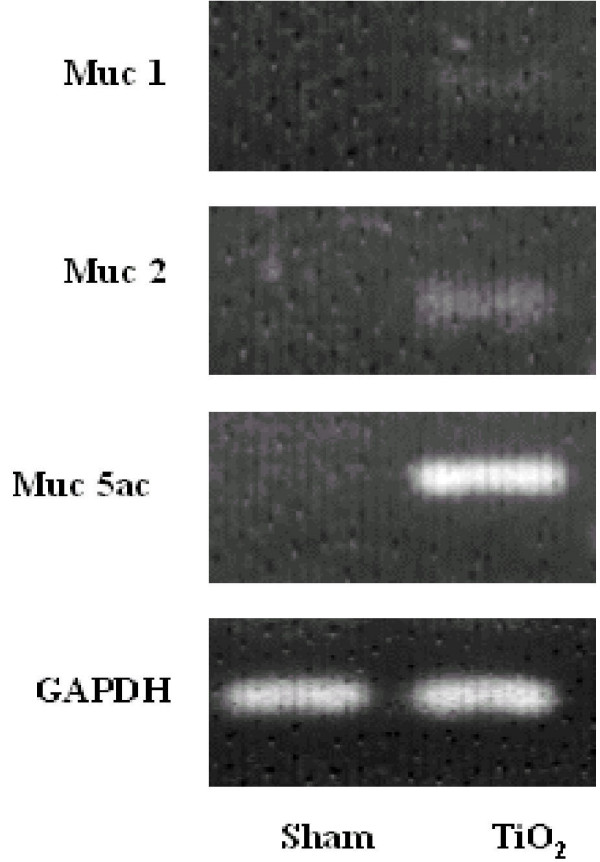
The expression of Muc1, Muc2 and Muc5ac mRNA in TiO2 treated rats. Rats were treated with TiO2, as described in Methods. Twenty-four hours after treatment, the levels of the Muc gene transcripts in the trachea were quantified using RT-PCR. GAPDH was used to ensure an equal loading of RNA samples. This figure is representative of 4 experiments.